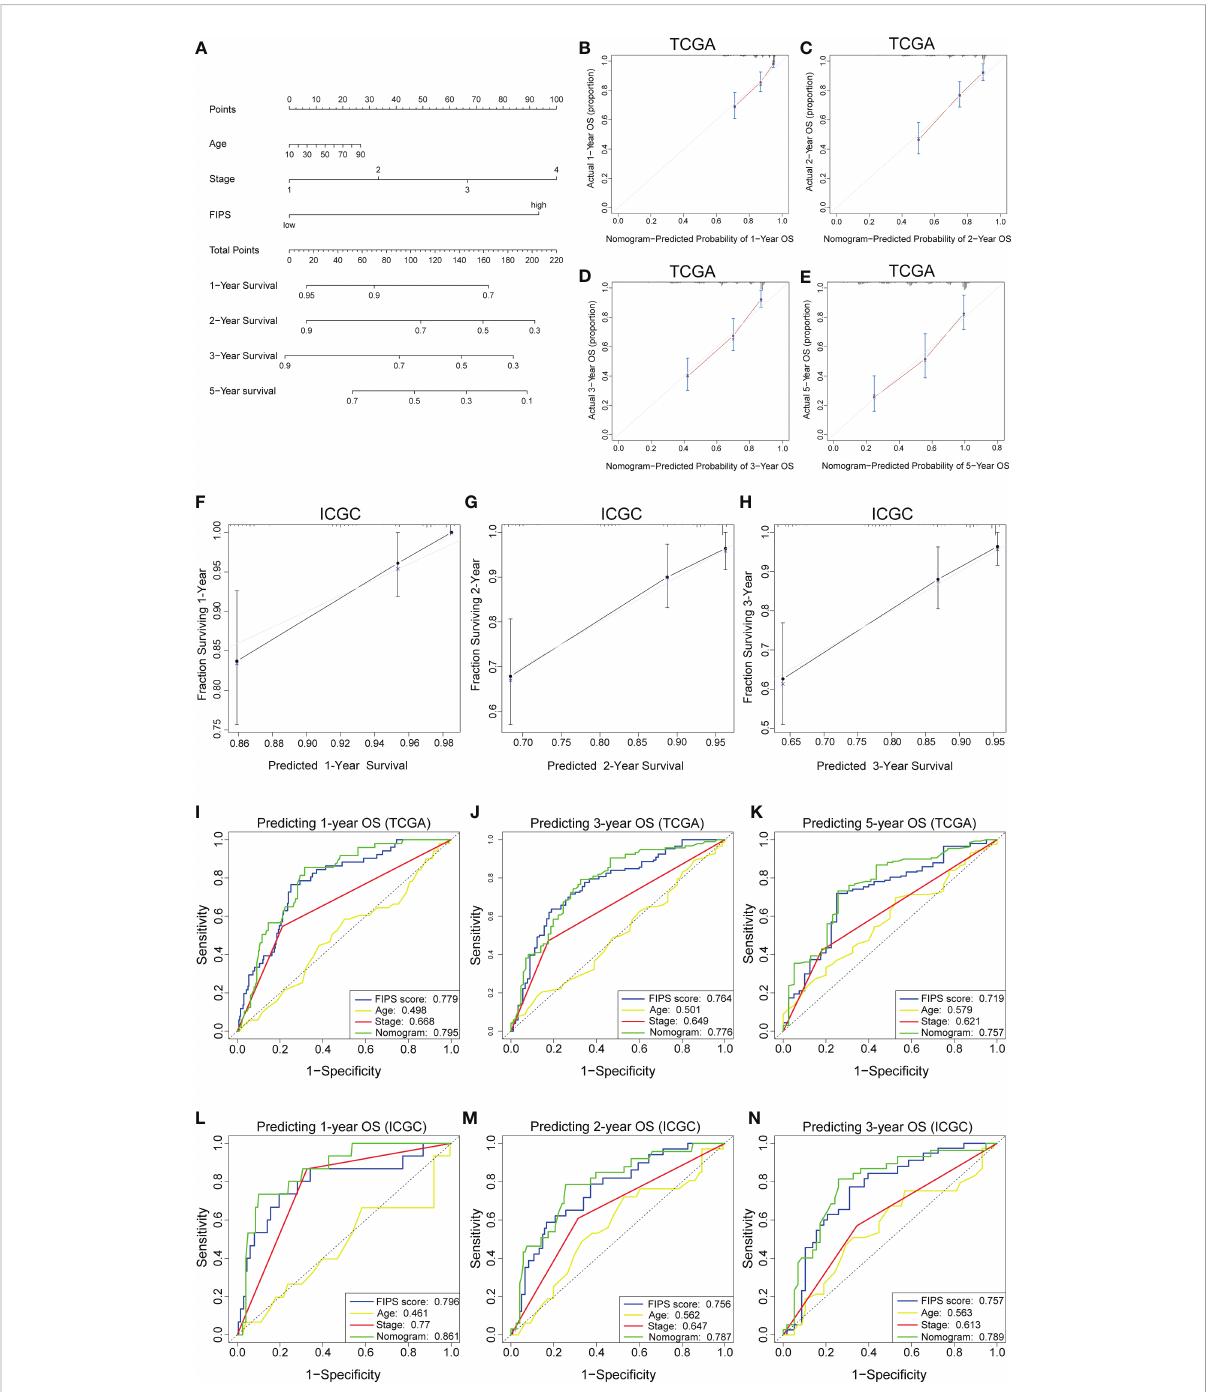
FIGURE 5 (A) Nomogram based on FIPS, age and TNM stage. (B-E) Calibration plots of the nomogram for predicting the probability of OS at 1, 2, 3, and 5 years in the TCGA cohort. (F-H) Calibration plots of the nomogram for predicting the probability of OS at 1, 2, and 3 years in the ICGC cohort. (I – K) Time-dependent receiver operating characteristic (ROC) curves for the nomogram, FIPS score, age and TNM stage in the TCGA cohort (for predicting 1, 3, and 5-year OS). (L – N) ROC curves for the nomogram, FIPS score, age and TNM stage in the ICGC cohort (for predicting 1, 2, and 3-year